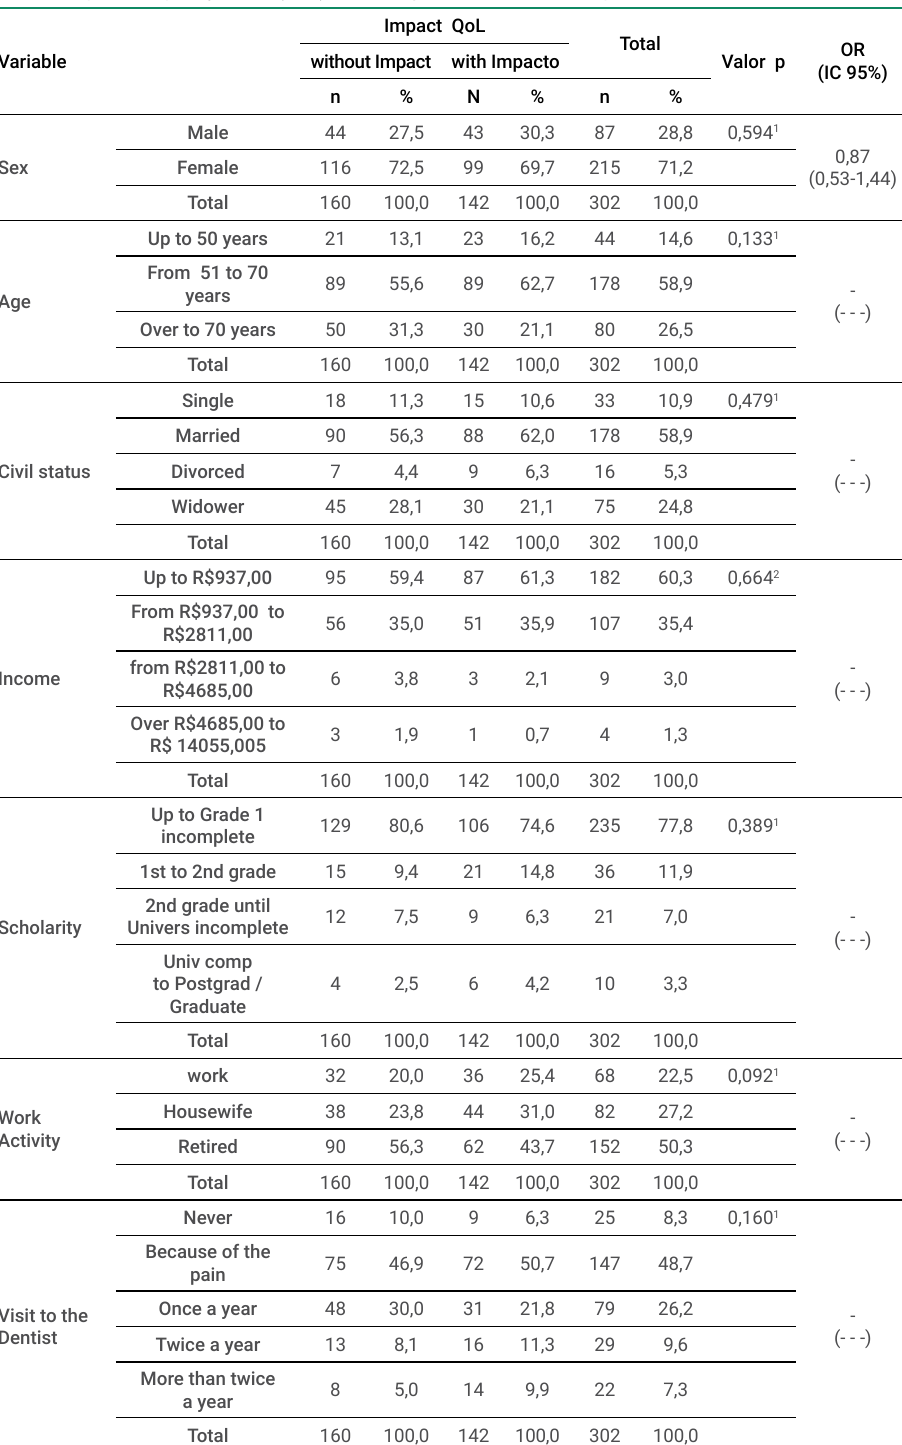
Table 5. Impact on quality of life (QoL) according to the variables independentes